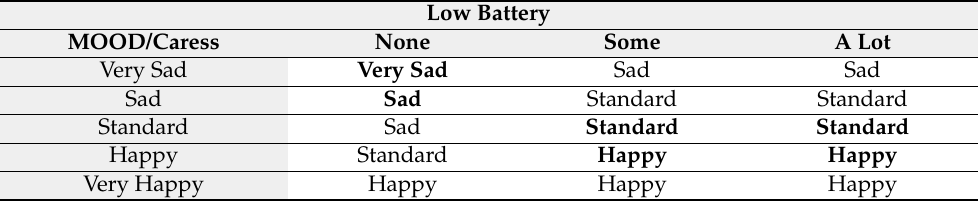
Table 7. Low- battery caress/MOOD rule chart. The gray cells represent the different MOOD and Caress labels defined. Bold respresents steady states.